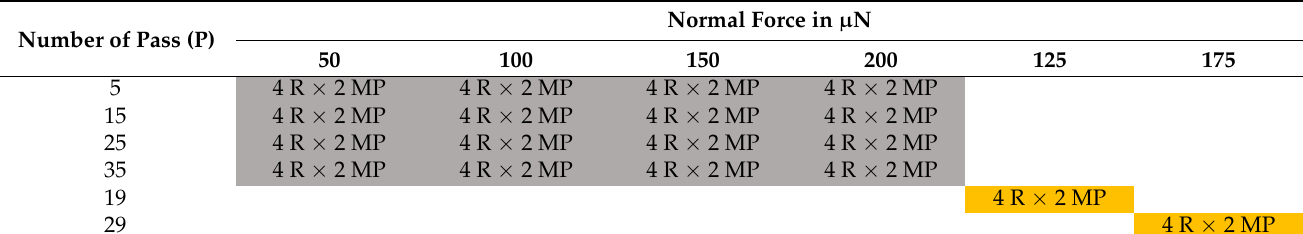
Table 2. Test matrix for the wear test for modeling and validation of the wear model with repetition (R) and measuring point